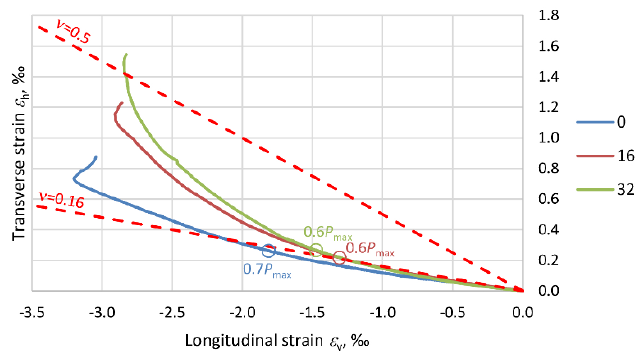
Figure 15. Graphs showing the variation of Poisson’s ratio ν for columns C_2H.